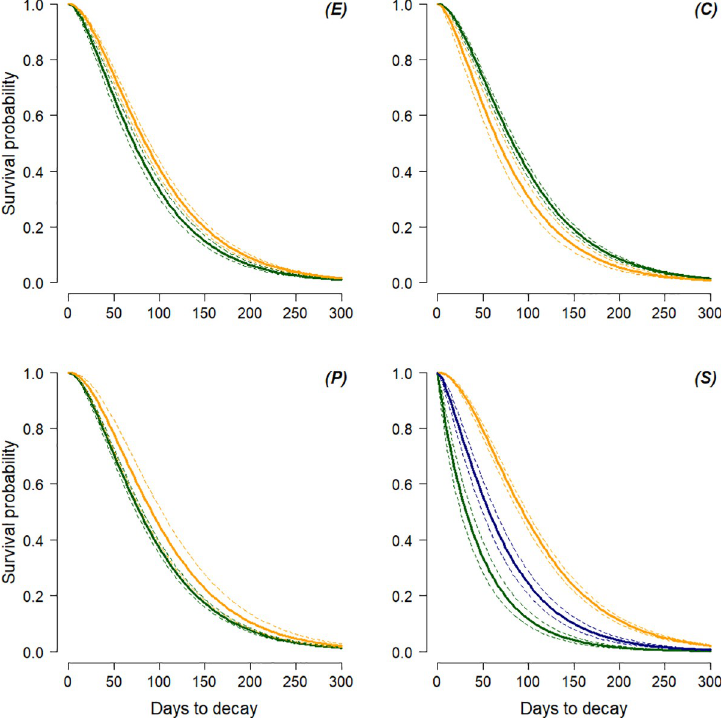
Fig 5. Factors influencing nest survival. Survival curves (bold, coloured lines) and 95% confidence intervals of the mean (dotted, coloured lines) for: (E) Exposure of nest: “Open” (orange) and “Closed” (green); (C) Construction type: “Integrated” (orange) and “Single tree” (green); (P) Position: “Side branch” (green) and”Top” (orange); (S) Nest exposed to number of storms: “Low” (green),”Medium” (orange) and “High” (blue).